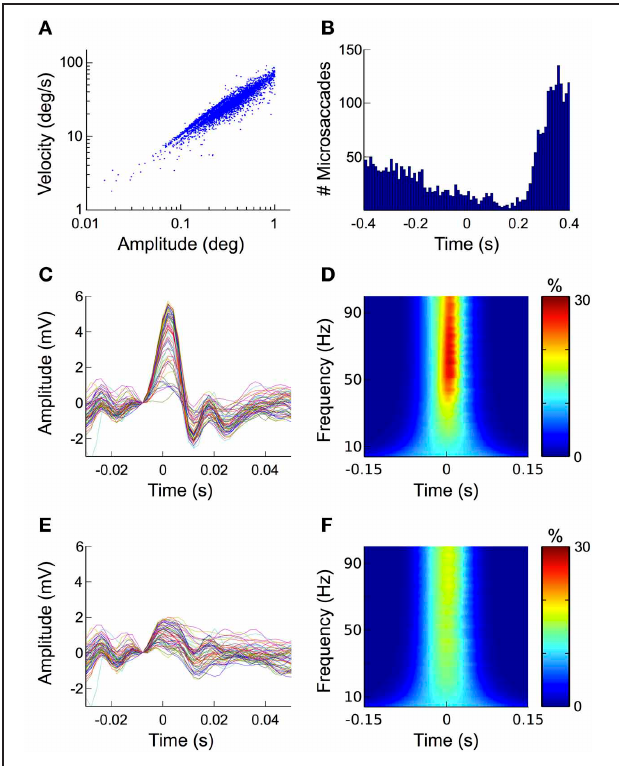
FIGURE 7 | Microsaccades. (A) Mainsequence. Plotting microsaccade amplitudes against microsaccade velocities results in a straight line on a log/log scale (i.e., the mainsequence). This relationship is a signature for ballistic eye movements, thus confirming the physiological origin of the microsaccades detected here. (B) Histogram of the microsaccade distribution over all fixation trials. After stimulus onset the frequency of microsaccades decreases, followed by a rebound starting at around 200ms and peaking 370ms after stimulus onset. (C) ERP aligned to microsaccade onset. At scalp electrodes microsaccades display a similar biphasic pattern as the saccadic spike potential, suggesting that the most prominent contribution of microsaccades to the signal measured on the scalp is produced by spike potentials going along with eye movement. (D) Time-frequency signature of microsaccades. The sharp peak of the microsaccade-related spike potential results in a transient broadband power burst that spans over the entire gamma frequency range (30–100Hz). (E) Reduction of microsaccade-related artifacts in the time domain. The ICA-based correction procedure proposed here diminishes the microsaccade-related spike potential to about one third of its original amplitude. (F) Reduction of microsaccade-related artifacts in the frequency domain. Corresponding to what was observed for the ERP, the correction procedure substantially reduces the spike potential-related frequency signature in the gamma